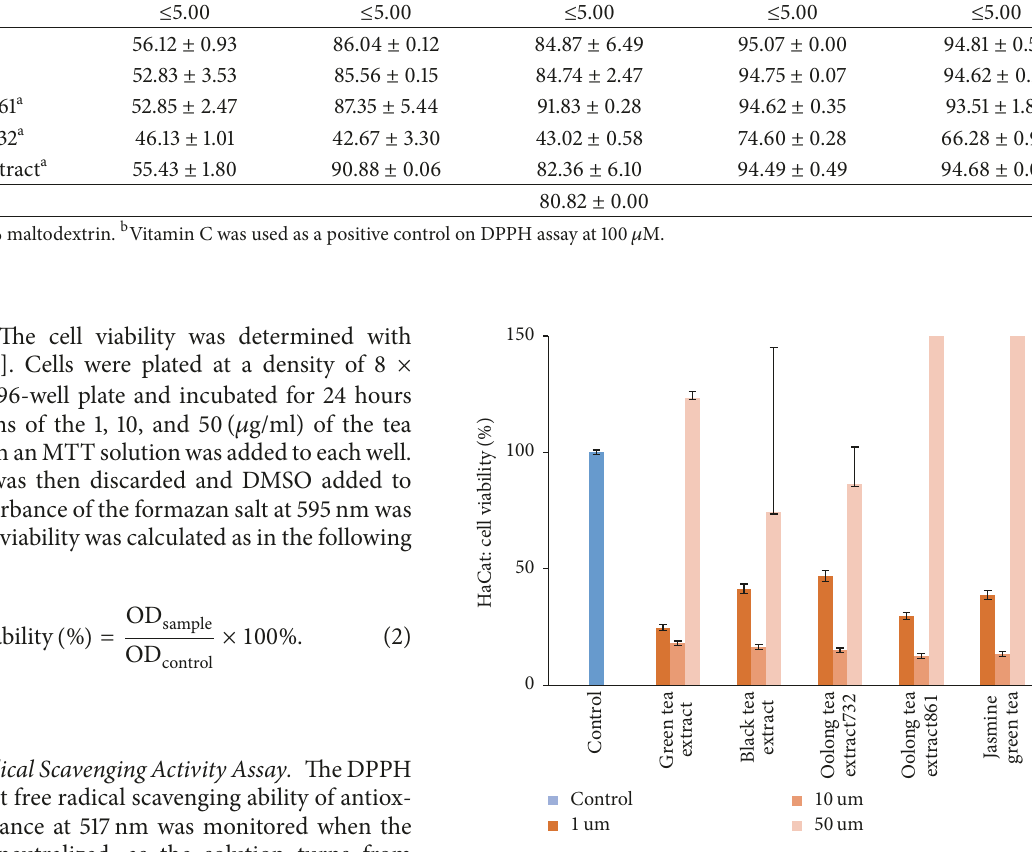
Figure 1: Effects of five extracts on cell viability of normal human cell and malignant melanoma cell according to MTT assay. Per- centage of cell viability was measured in HaCat cultured with 1 𝜇 m, 10 𝜇 m, and 50 𝜇